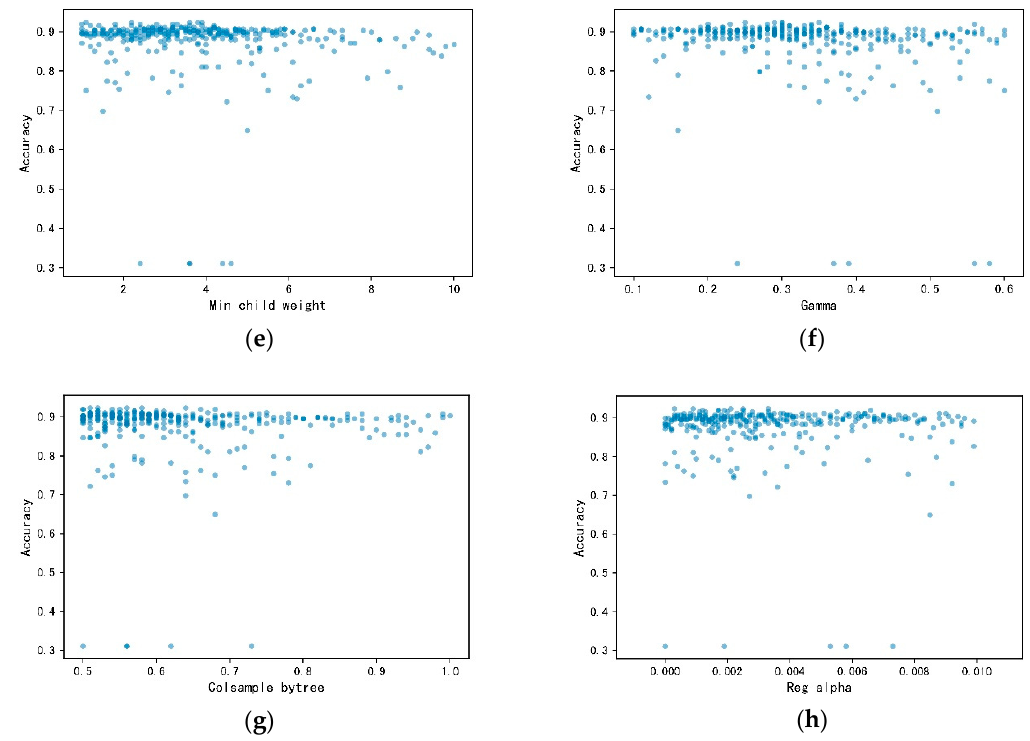
Figure 4. The XGBoost parameters tuning process by BO. ( a ) Max depth tuning process; ( b ) number of estimators tuning process; ( c ) learning rate tuning process; ( d ) subsample tuning proces€( e ) minimum child weight tuning process; ( f ) gamma tuning process; ( g ) consample bytree tuning process; ( h ) reg alpha tuning process.